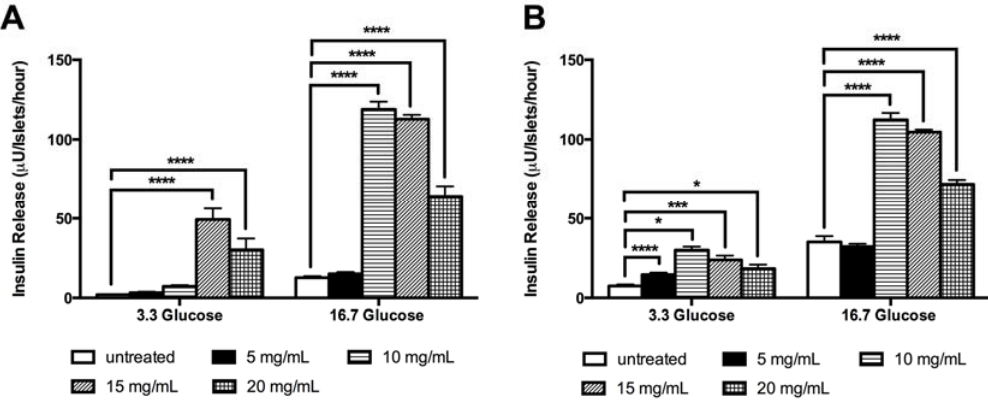
Figure 4. LM induces in vitro insulin release in batch incubated islets. The insulin release was evaluated in batch incubated GK rat islets ( A ) and W rat islets ( B ) incubated with low (3.3 mM) and high (16.7 mM) glucose in presence of LM (5–20 mg/mL). Insulin concentration was measured by RIA. The data are presented as means ± standard error of the mean SEM ( n = 8). * p < 0.05, *** p < 0.001, **** p < 0.0001 when compared to untreated islets.